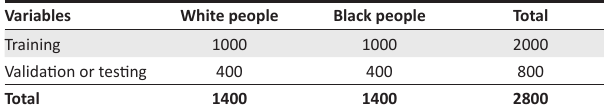
TABLE 1: Number of training and validation images for dataset 1.